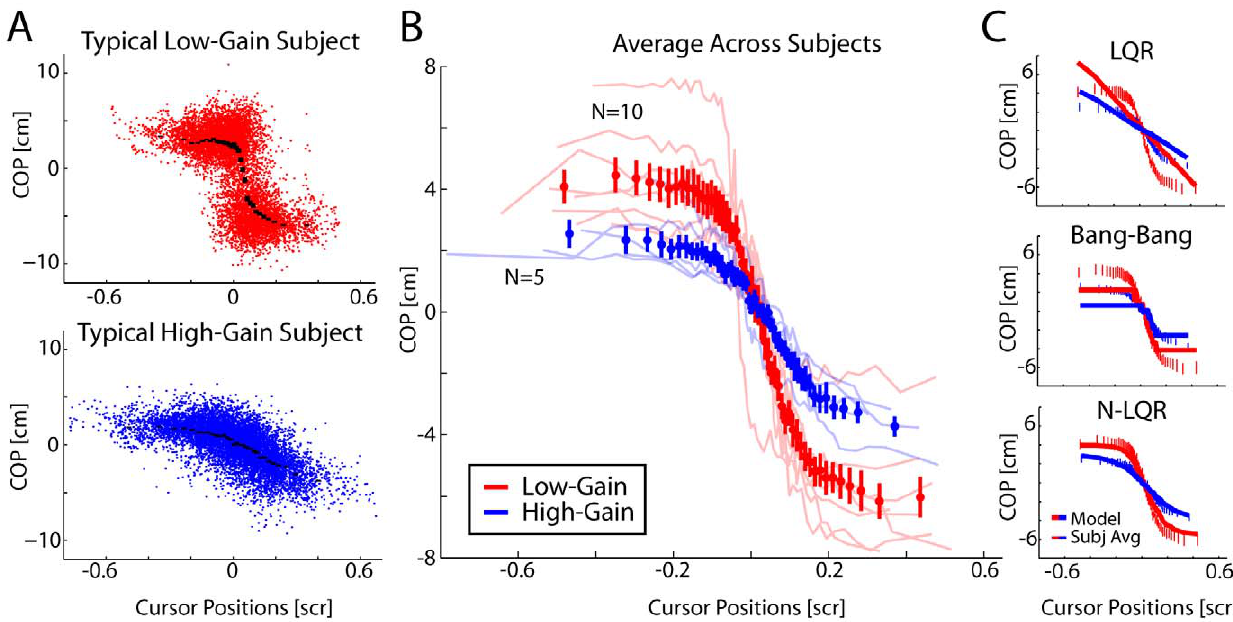
Figure 5. Policies as a function of position. A) Center of pressure as a function of cursor position for typical subjects in the low and high-gain conditions. Black lines denote median responses for a given range of cursor positions. Red and blue points denote samples along the COP trajectory. B) Average responses across subjects with thin lines denoting the responses of individual subjects. C) The predicted responses from the LQR, Bang- bang, and Non-linear LQR models. Error bars denote SEM across subjects (in B and C) and sample points (in A).